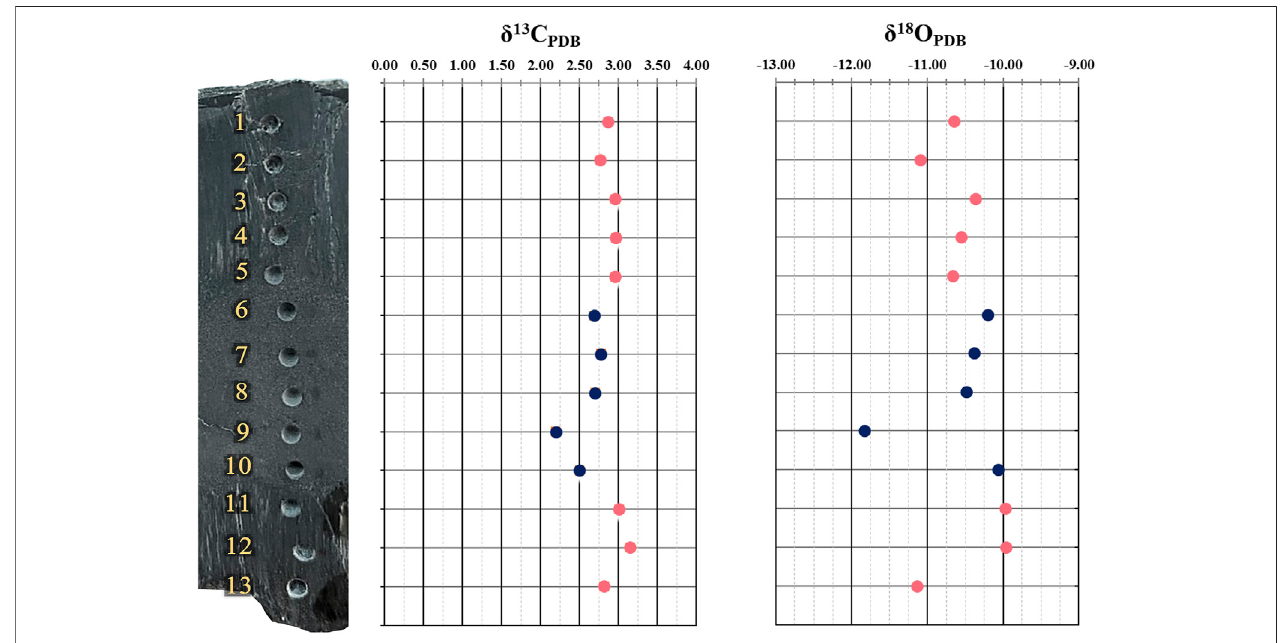
FIGURE9| ThetransectiondiagramoftheKhaoKhwangsample(KK-5)shows δ 13 CPDBand δ 18 OPDBisotopiccompositionofhostrock(blackdots)and fi brous calcite veins (red dots) from top to bottom of the samples. The boundary between the fi brous calcite vein and host rock is indicated by yellow dashed lines.